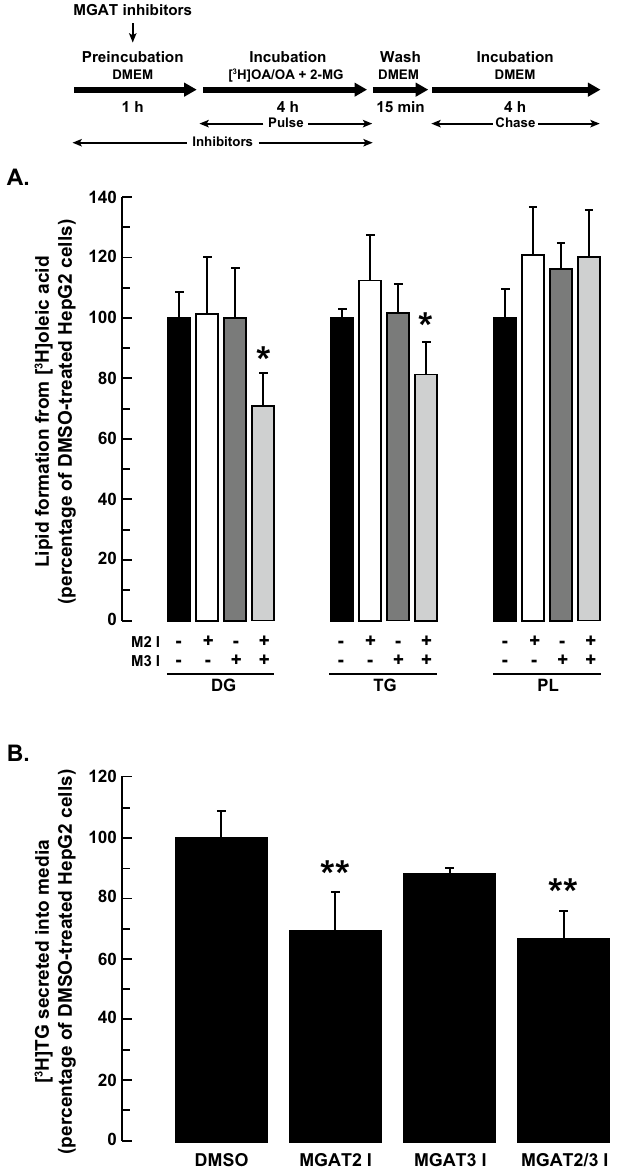
Figure 3. Effect of MGAT inhibition on lipid production from exogenous 2-MG and oleic acid. HepG2 cells were pre-incubated with or without the MGAT2 inhibitor (25 µM), MGAT3 inhibitor (50 µM) or both inhibitors together. After 1 h, 5 µCi [ 3 H]OA, cold OA (0.25 mM final concentration) and 2-MG (0.2 mM final concentration) were added to the culture media and cells were incubated for a further 4 h. Cells were then washed and incubated an additional 4 h in DMEM. The incorporation of radioactivity into ( A ) TG, DG and PL in cells and ( B ) TG in media, was then determined. Values for DMSO-treated controls: DG (18.1 × 10 3